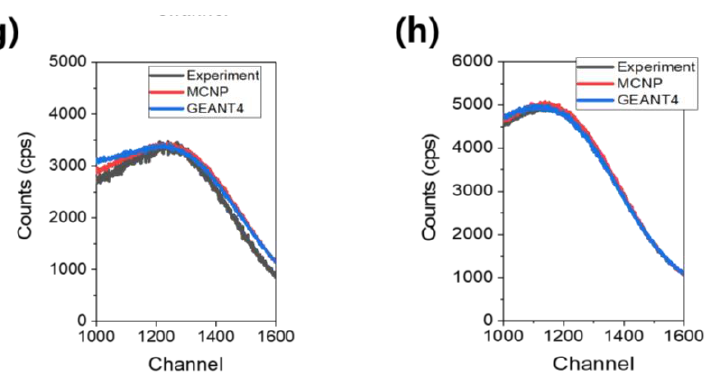
Figure 10. Experimental results and computational simulation results of commercial and CdS/ZnS-